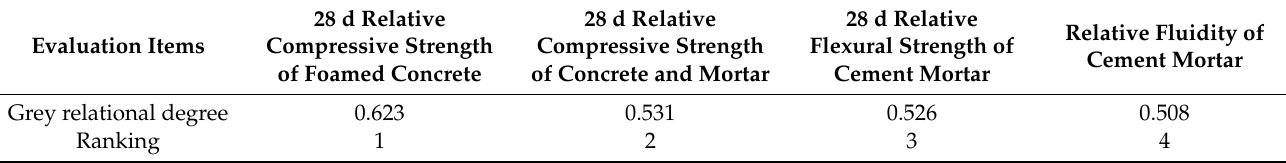
Table 7. Grey relational